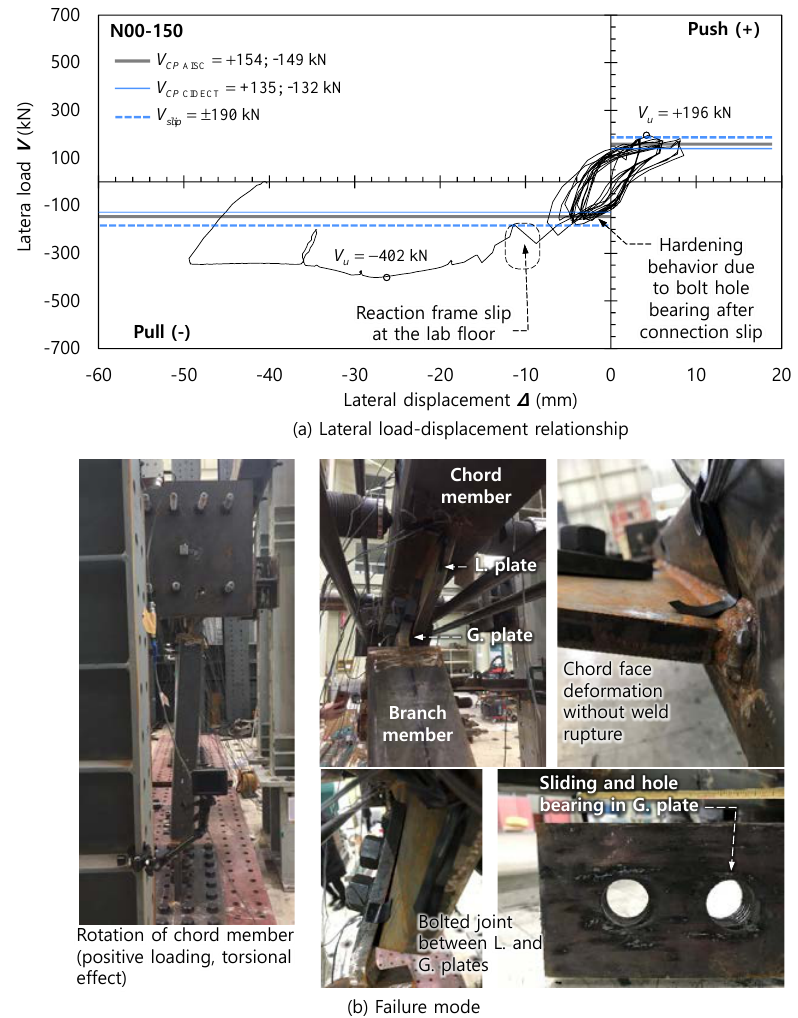
Figure 6. Test results of unsti ff ened plate-to-RHS connection: N00-150: ( a ) Lateral load-displacement relationship; ( b ) Failure